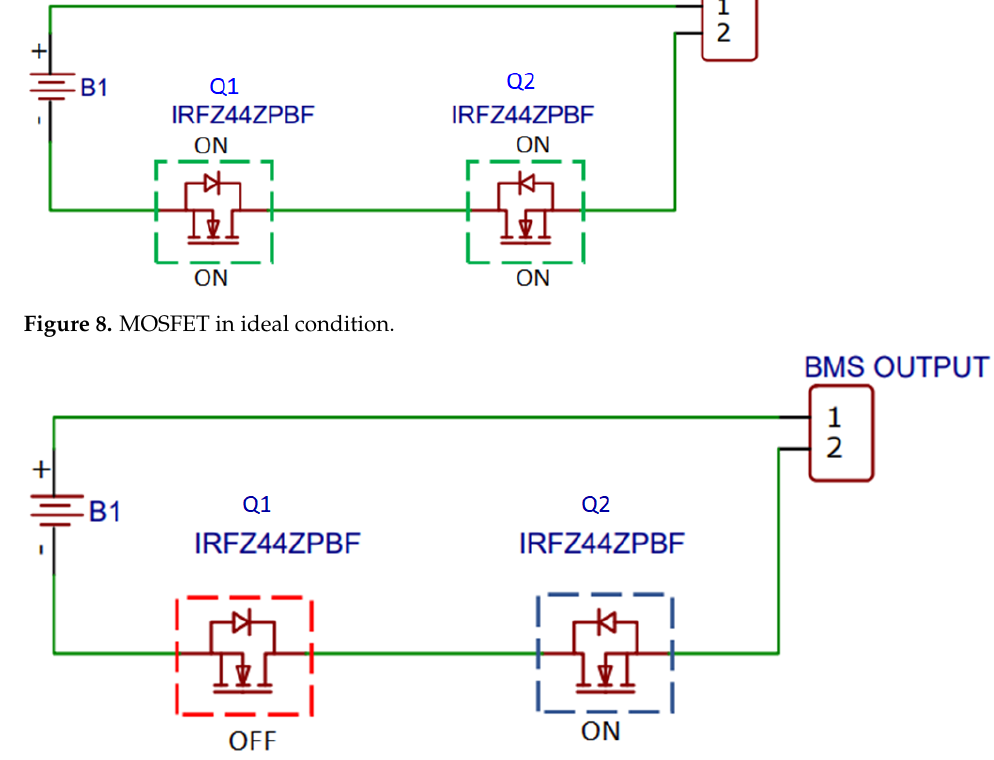
Figure 9. MOSFET in overcharge condition.